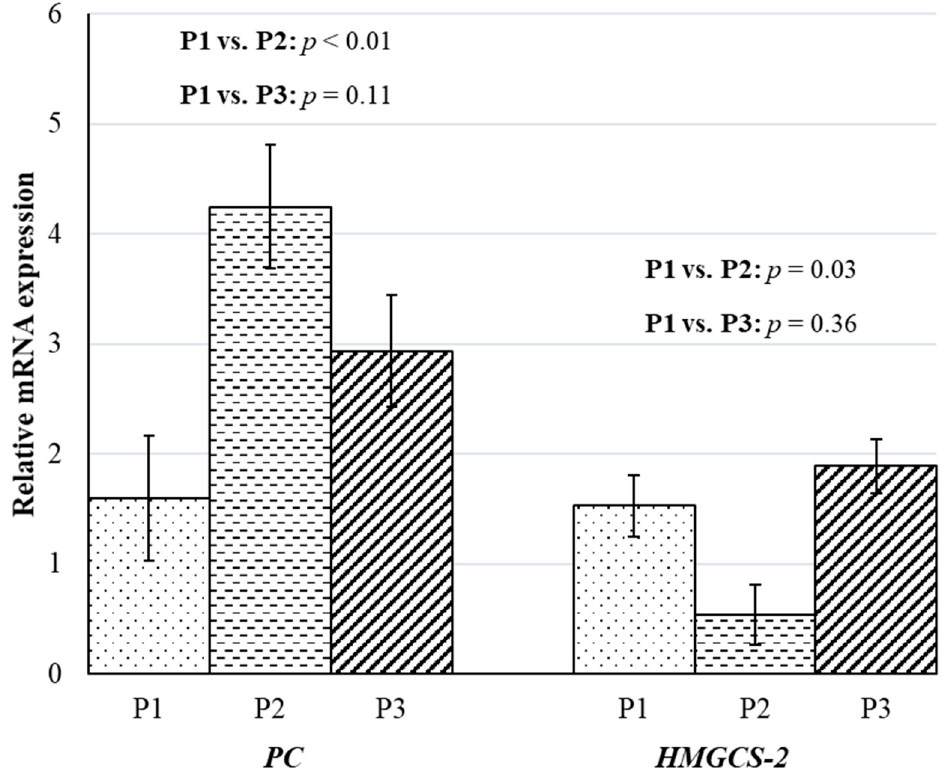
Figure 3. Impacts of time-fed concentrate-based diets on relative mRNA expression of rate-limiting gluconeogenic and ketogenic enzymes of wethers. The experiment was divided into three phases: P1 (day 0 to 21), P2 (day 22 to 25), and P3 (day 22 to 49). During P1, all wethers ( n = 13) were fed the 80% forage diet. On day 22, the remaining nine wethers were fed an 80% concentrate diet. The contrasts between wethers sampled in P1 ( n = 4) and P2 ( n = 4) and between wethers sampled in P1 ( n = 4) and P3 ( n = 5) on LS means of relative mRNA expression of Pyruvate carboxylase ( PC ) and 3-hydroxy-3- methyl-glutaryl CoA-synthase ( HMGCS-2 ) in liver tissue.